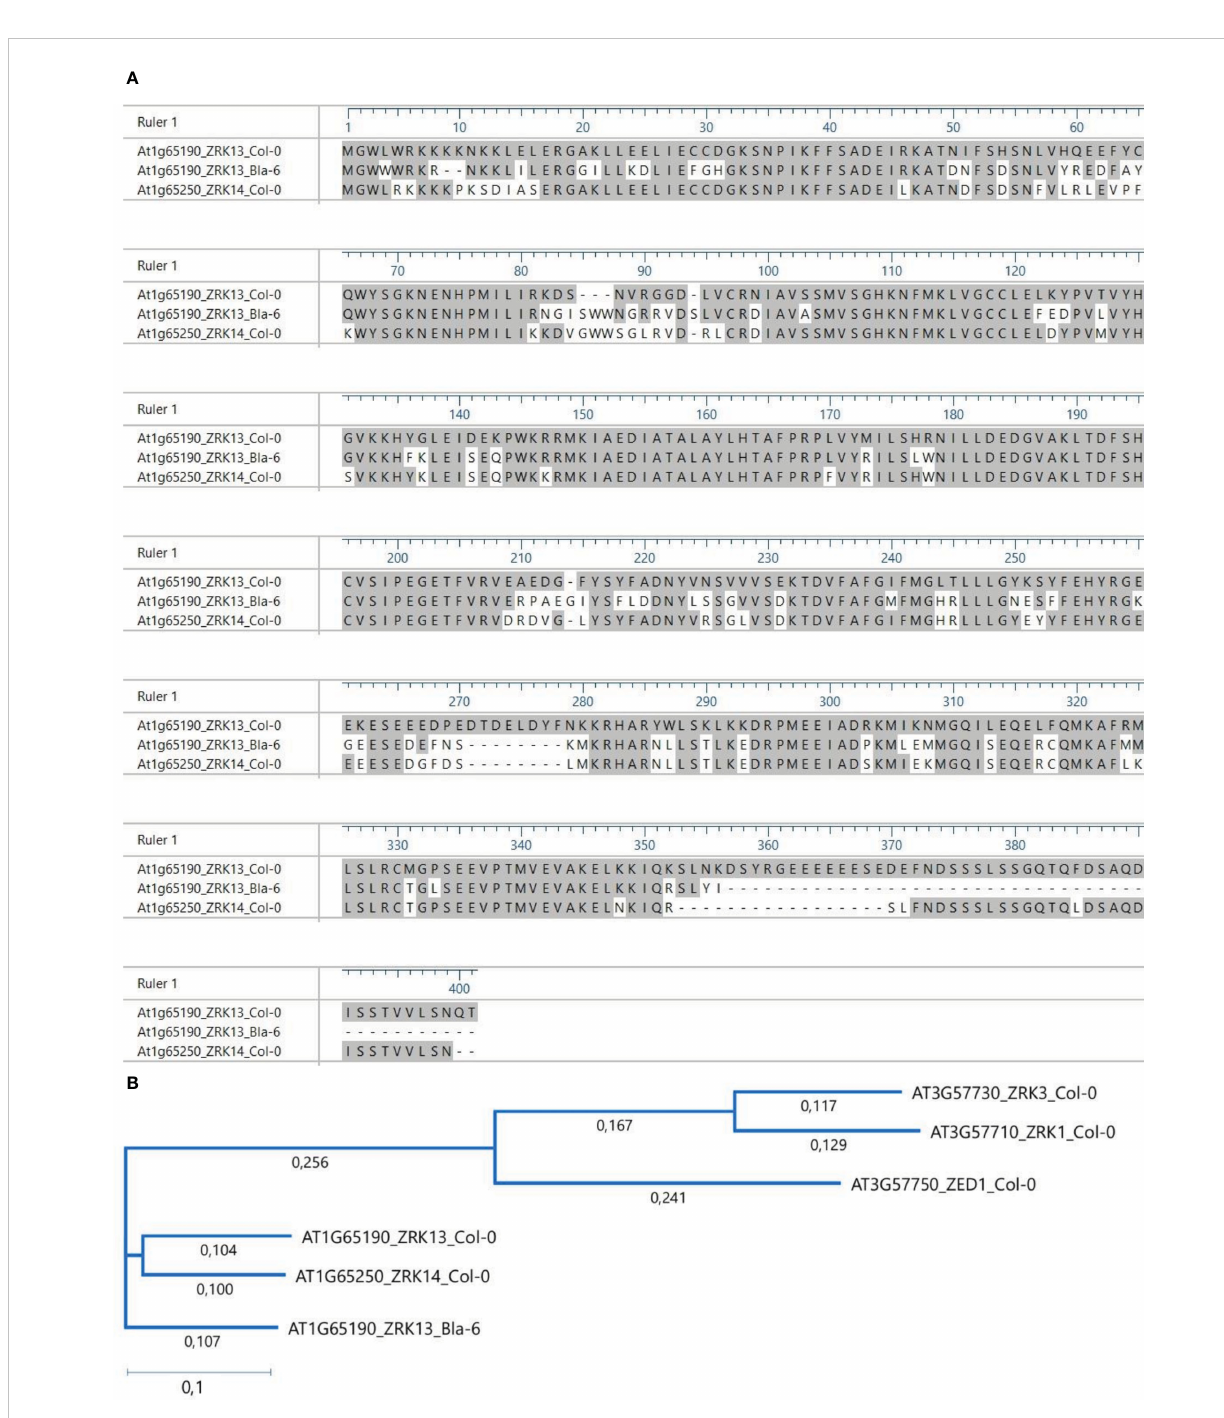
FIGURE 3 Alignment of the predicted protein sequence of ZRK13 allele of Bla-6 with the ZRK13 and ZRK14 alleles of Col-0. (A) Conserved amino acids are shown in grey. (B) Phylogenetic tree of some of the ZRK genes on chromosome 1 (ZRK13, ZRK14) and 3 (ZRK1, ZRK3,